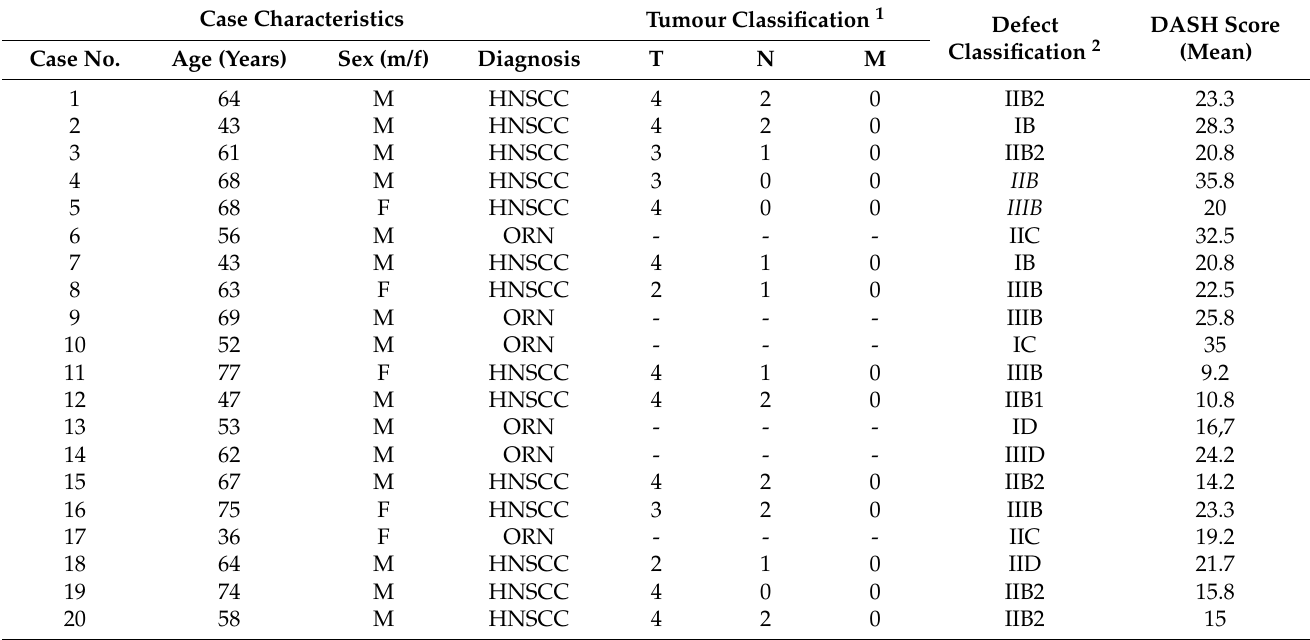
Table 1. Case characteristics and postoperative individual DASH